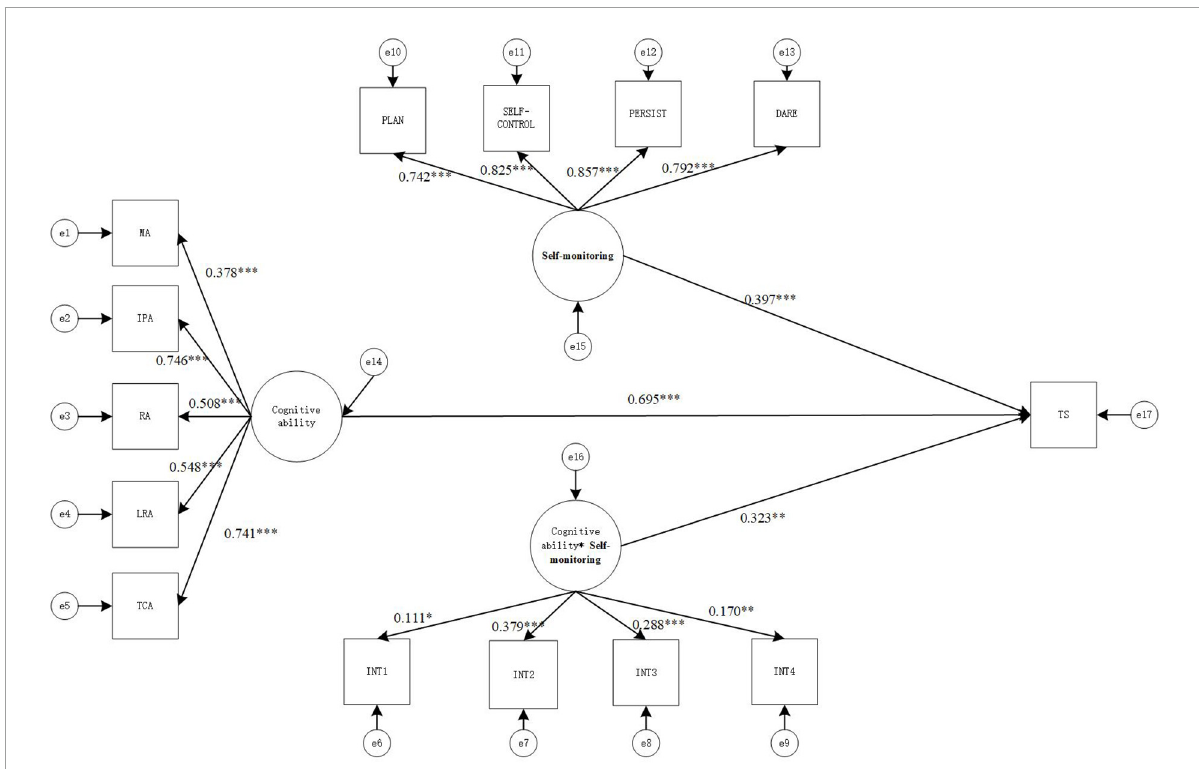
FIGURE1 Structural equation moderating effect relationship model diagram (model 1). MA, memory ability; IPA, information processing ability, RA, representation ability; LRA, logical reasoning ability; TCA, thinking conversion ability; TS- academic performance. * p < 0.05, ** p < 0.01, and *** p < 0.001.